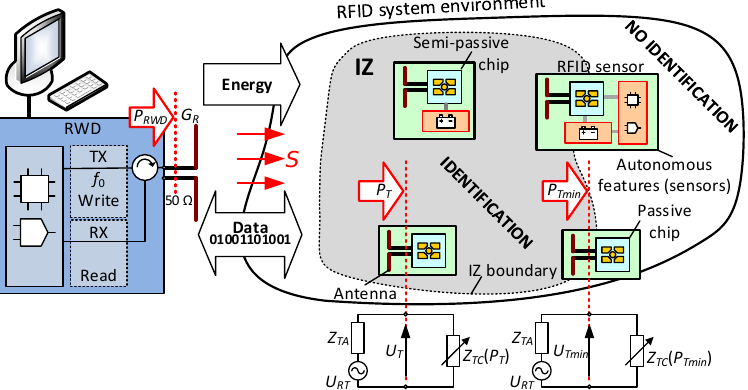
Figure 1. General diagram of an ultrahigh-frequency (UHF) radio-frequency identification (RFID) system. The interrogation zone (IZ) is space in which communication process can be carried out and thus where the unique identification number (UID), user data and measured parameters can be read (or written with user data).